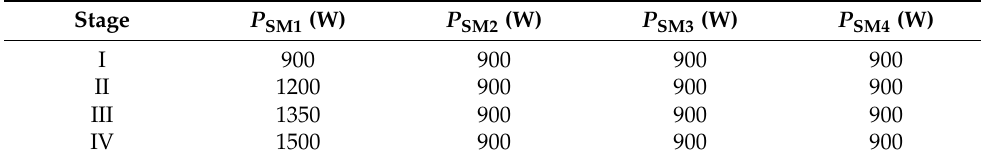
Table 4. Stepwise sub-module power reference.